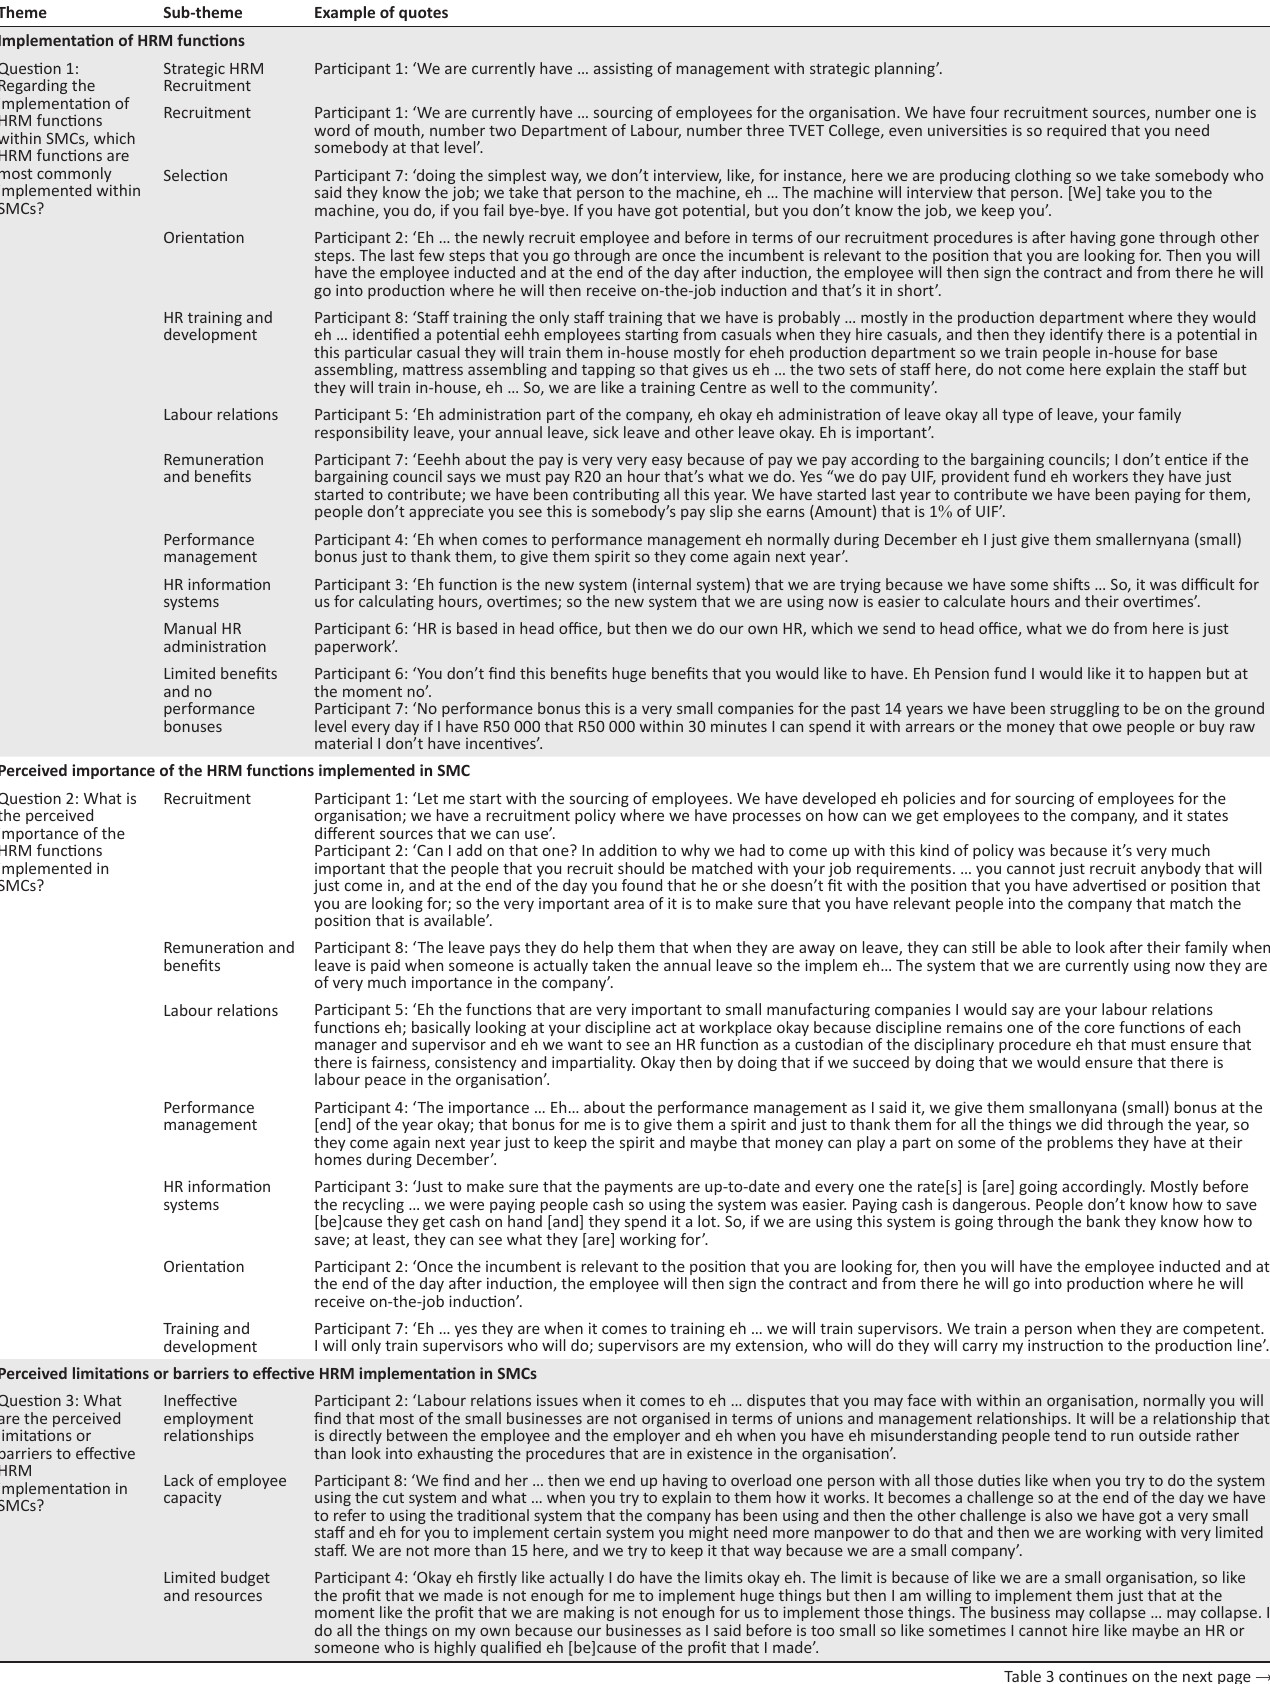
TABLE 3: Summary of the core themes about implementation and perceived importance of human resource management functions as well as perceived limitations or barriers to effective human resource management implementation in small manufacturing companies. Theme Sub-theme Example of quotes Implementation of HRM